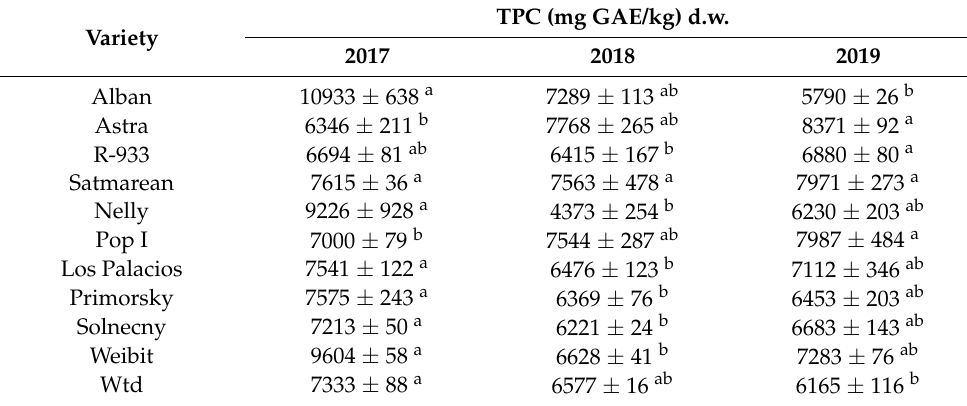
Table 1. Relation of the year of cultivation to polyphenols content in seeds of white lupin (mg GAE/kg d.w., means ± standard deviations of four independent determinations). TPC (mg GAE/kg) Variety